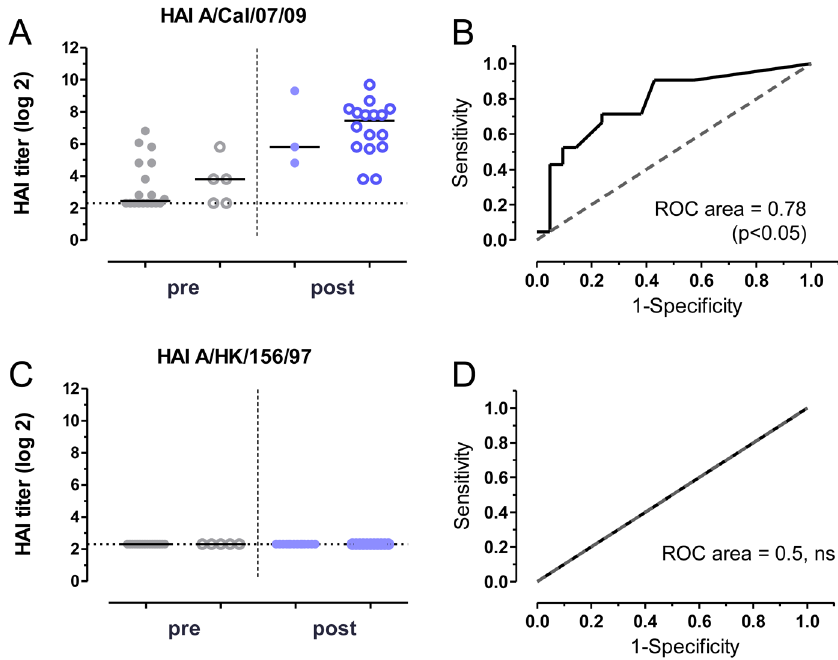
Figure 3. Serum HAI titers correlate with protection against H1N1 but not H5N1 challenge. HAI titers against ( A ) A/California/07/2009 (H1N1) and ( C ) A/Hong Kong/156/97 (H5N1) were determined. Titers for mice that survive challenge (open circles) and mice that succumb to infection (closed circles) are presented separately for pre-vaccination (pre) and post-vaccination (post) sera. Assay background level is indicated with dashed line in panels A and C. Vaccine homologous H1 HAI titers are higher in post-vaccination serum (p , 0.001, t-test), while H5 HAI titers are undetectable. Receiver-operator characteristic (ROC) curves were calculated to assess the correlation ( B ) between HAI titers against A/California/07/ 2009 (H1N1) virus and survival following A/Netherlands/602/2009 (H1N1) challenge, and ( D ) between HAI titers against A/Hong Kong/156/97 (H5N1) virus and survival following A/Hong Kong/156/97 (H5N1) challenge. H1N1 HAI correlates with protection against homologous H1N1 challenge (ROC area=0.78, p , 0.05, 95% confidence interval (CI) 0.64–0.92). ns, not